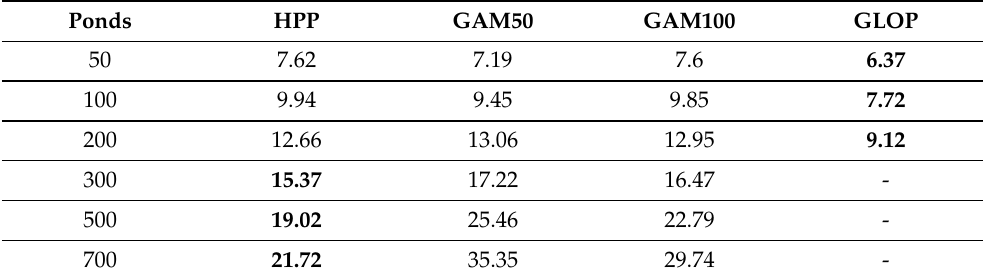
Table 1. Average Total Cost.